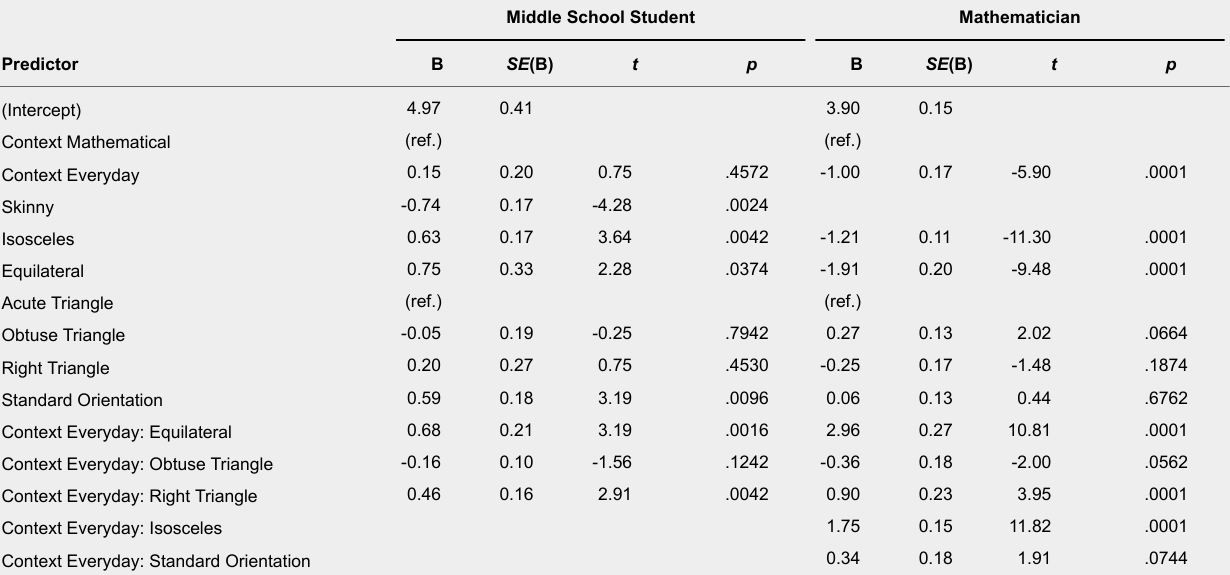
Middle School Students’ (Left) and Mathematicians’ (Right) Regression Model Outputs for the Impact of Mathematical and Everyday Properties of Triangles on Typicality Ratings Middle School Student Predictor